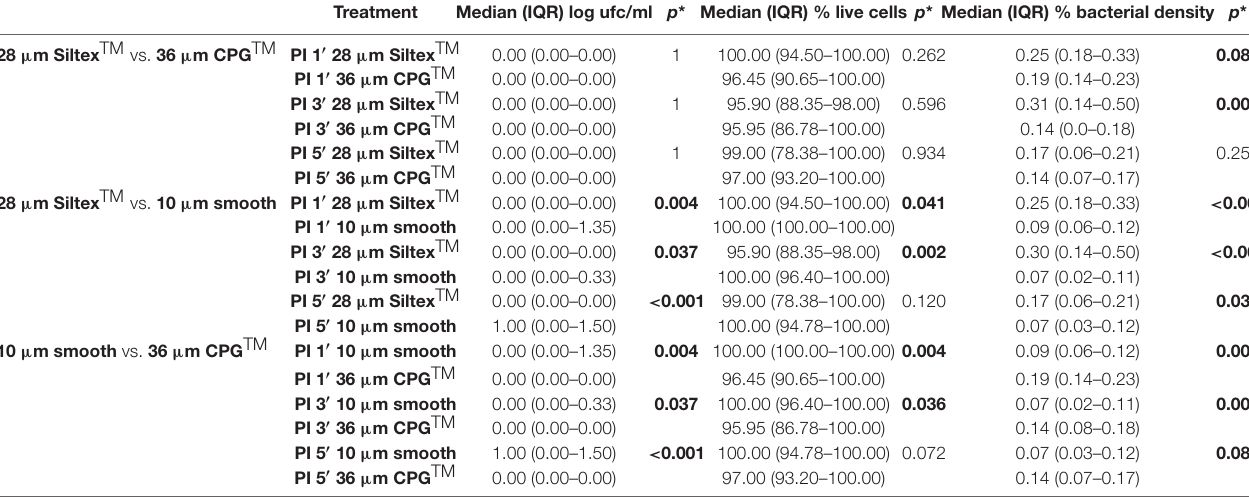
TABLE 2 | Comparative results for povidone iodine at three times of exposure according to Mentor R (cid:13) implants. Treatment